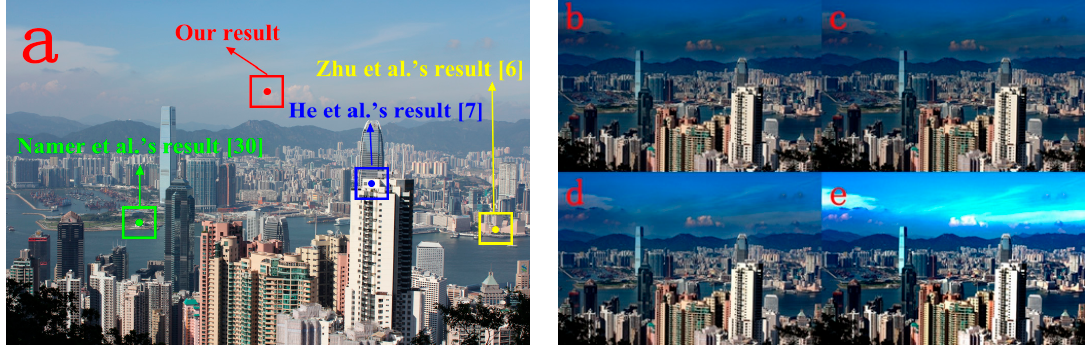
Figure 6. A challenging hazy image for the atmospheric light locating comparison and the recovery effect comparison of different atmospheric light estimation results. ( a ) Atmospheric light locating comparison, the results of [6,7,33] and ours are depicted in boxes with different colors. ( b – e ) The recovery effect comparison; the images are recovered using different atmospheric light estimation results that are obtained via [6,7,33] and ours, respectively.